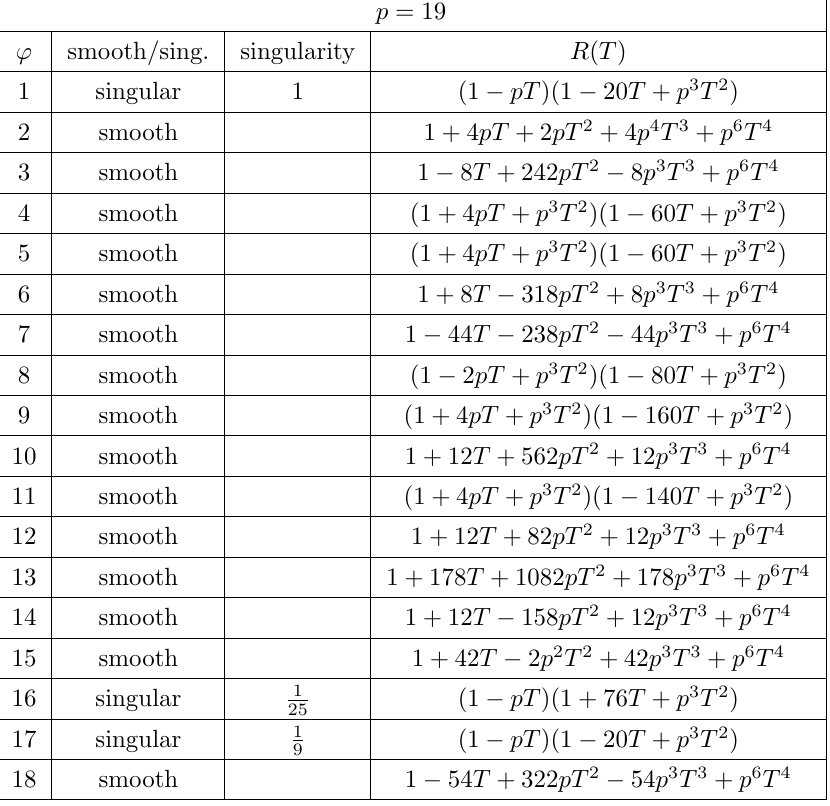
Table 1 . The R -factors for ’ 2 F 19 . Note the factorisations into two quadrics for the (cid:12)ve values ’ = 4 ; 5 ; 8 ; 9 ;